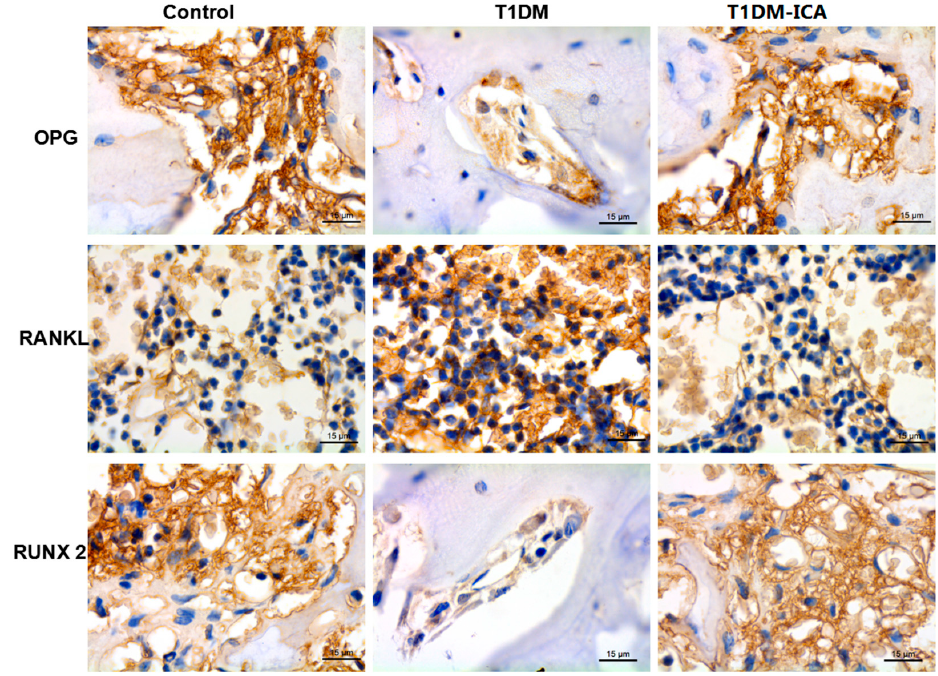
Figure 8. OPG, RANKL, and RUNX 2 protein expression in the femoral bone tissues of each group. The immunohistochemical staining, the cells with positive expression of OPG, RANKL, and RUNX 2 are shown in brown. Magnification: